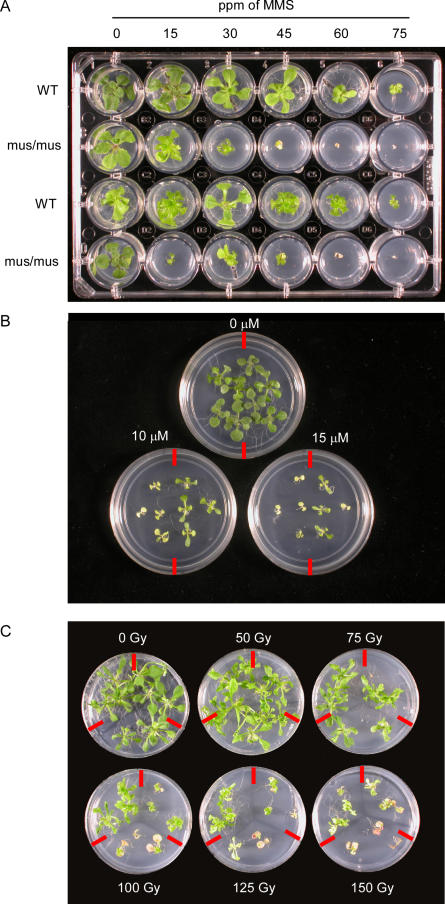
Hypersensitivity of Atmus81 Mutants to MMS, Cisplatin, and Gamma Radiation(A) Wild-type Col-0 (rows one and three) and mutant Atmus81/Atmus81 (rows two and four) were subjected to a gradient (0–75 ppm) of MMS. The photograph was taken after 20 d. The wild-type plants can grow at each concentration tested while the mutants cannot grow at >30 ppm MMS. (B) Wild-type Col-0 (right side of plate) and mutant Atmus81/Atmus81 (left side of plate) were subjected to various concentrations of cisplatin (0–15 ppm). The photograph was taken after 12 d. Wild-type plants consistently outperformed the mutants at all concentrations tested.(C) Wild-type Col-0 (upper left third), mutant Atmus81/Atmus81 (upper right third), and gamma-hypersensitive mutant atm-2/atm-2 (bottom third) were exposed to various levels of gamma radiation (0–150 Gy). At 75–100 Gy, the Atmus81 mutants resembled the atm-2 mutants rather than the wild-type plants.